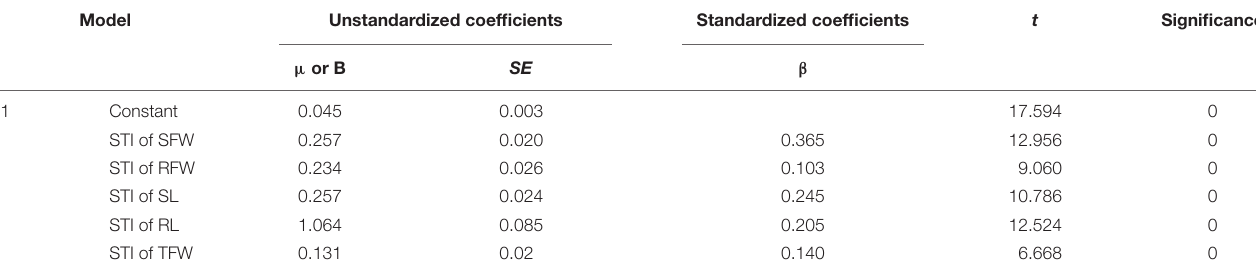
TABLE 2 | Multiple regression analysis for salt tolerance indices of shoot fresh weight (STI of SFW), root fresh weight (STI of RFW), shoot length (STI of SL), root length (STI of RL), and total fresh weight (STI of TFW) in the presence of 200 mmol L − 1 NaCl.